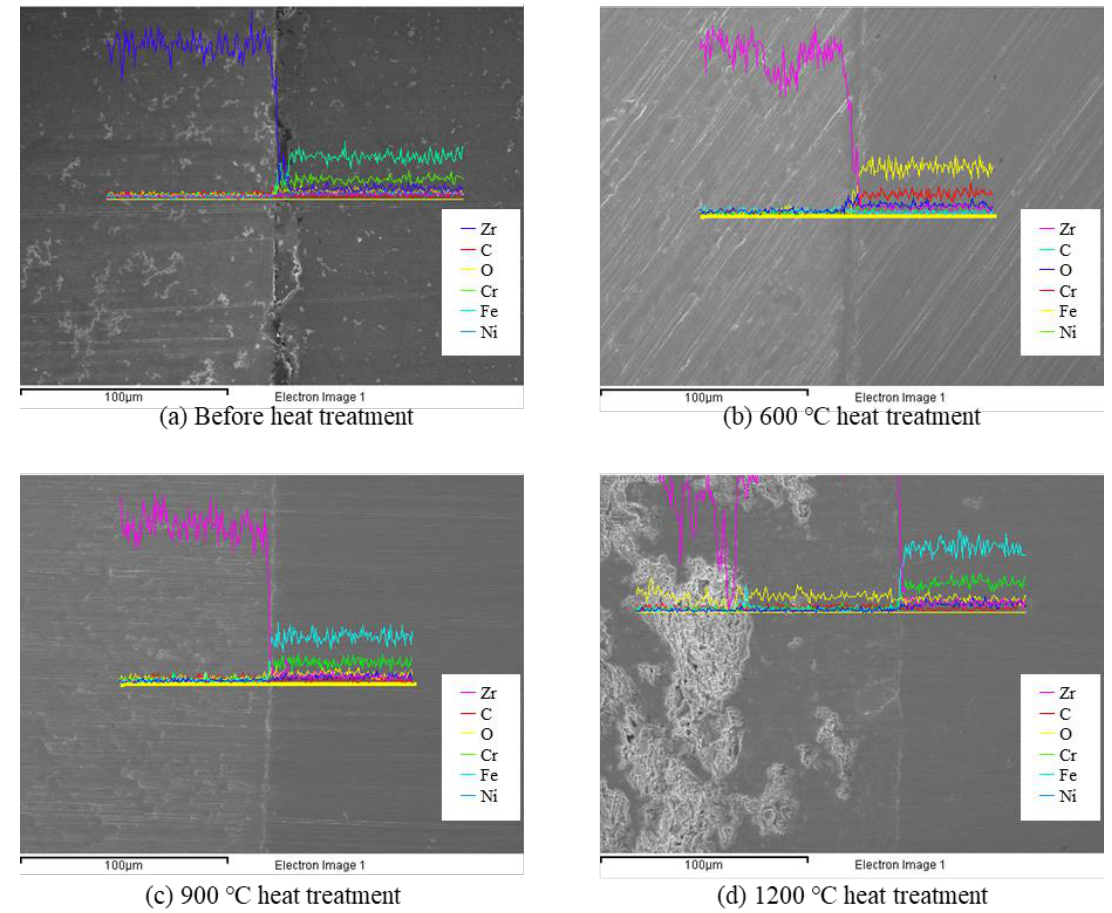
Figure 10. Energy-dispersive X-ray spectra of the PST before and after heat treatments at 600, 900, and 1200 °C for 1 h.